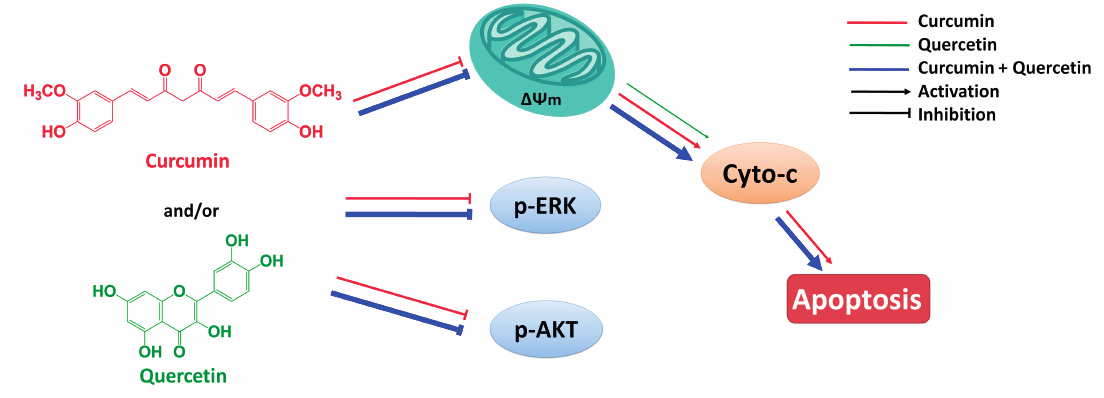
Figure 7. Combined effect of quercetin and curcumin on gastric cancer MGC803